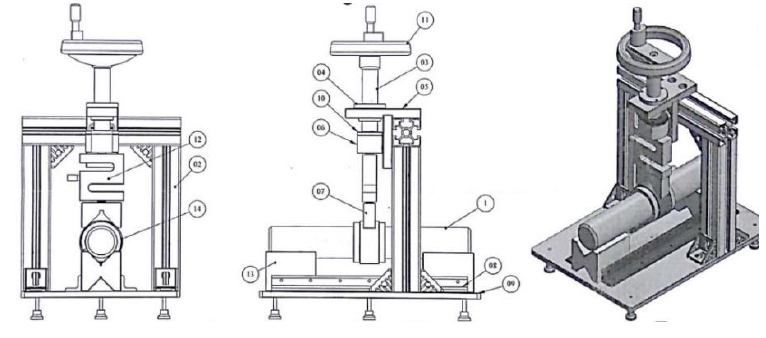
Figure 4. Views of static test